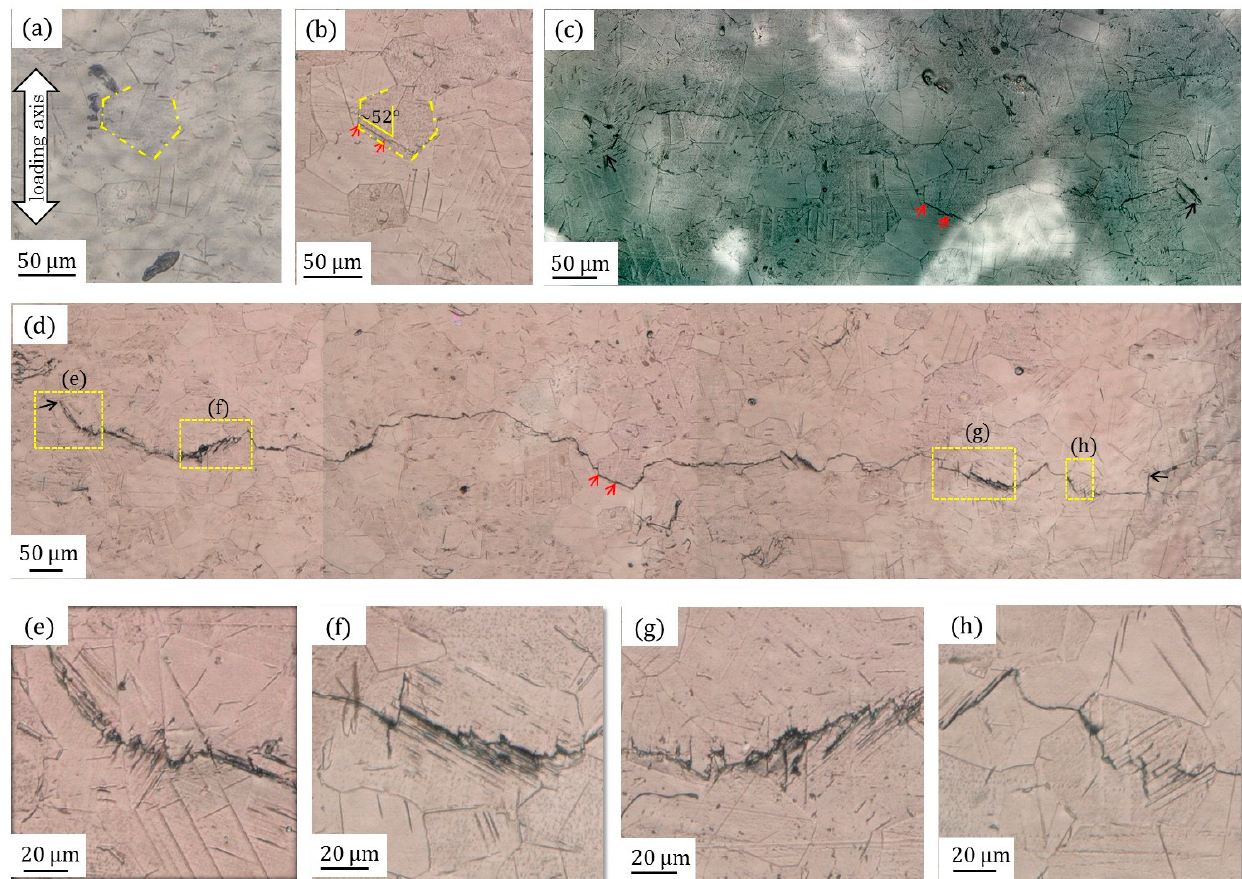
Figure 3. At 175 MPa: Images showing surface crack paths at different cycles: ( a ) Initial condition, i.e., N = 0 cycle; ( b ) After N = 2 × 10 5 cycles; ( c ) After N = 4 × 10 5 cycles; ( d ) After N = 6 × 10 5 cycles. The free ‐ shape object in ( a ) and ( b ) indicates a particular area where the crack started. The red arrows illustrate crack initiation sites, and black arrows delineate the crack tips. Examples of fine zig ‐ zag ( e , g ), crack branching ( f , g ), and crack interactions with slip bands ( e , h ).